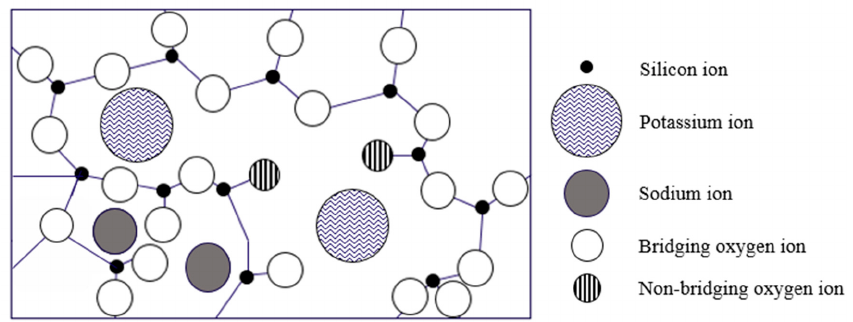
Figure 9. Schematic diagram of an ion exchange.